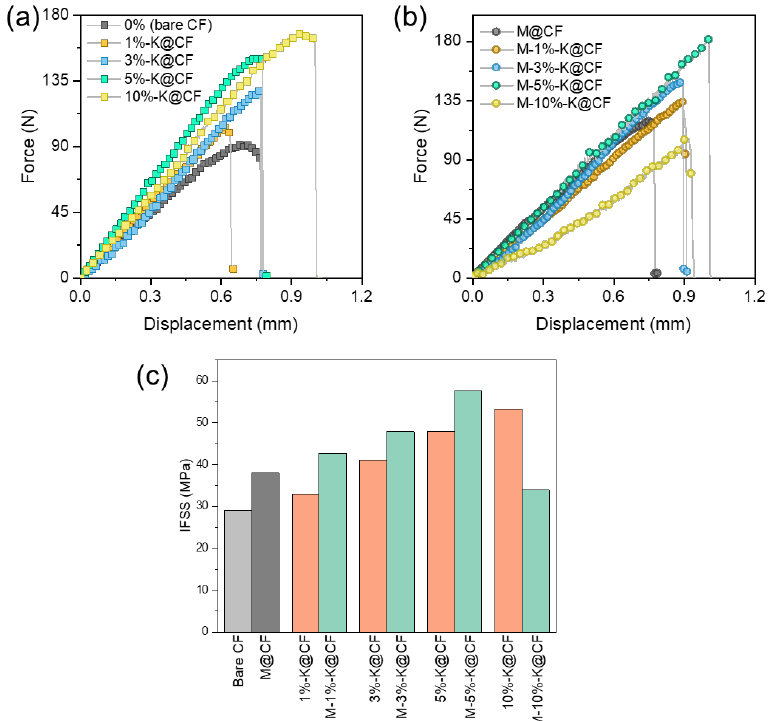
Figure 5. Bundle fiber pull-out tests. Force–displacement curves of ( a ) bare CF with and without KH560, and ( b ) MWCNT-modified CF in ( a ). ( c ) Interfacial shear strength (IFSS), estimated from ( a , b ), for bare CF, n-K@CF, M-n-K@CF, and M@CF in resin.